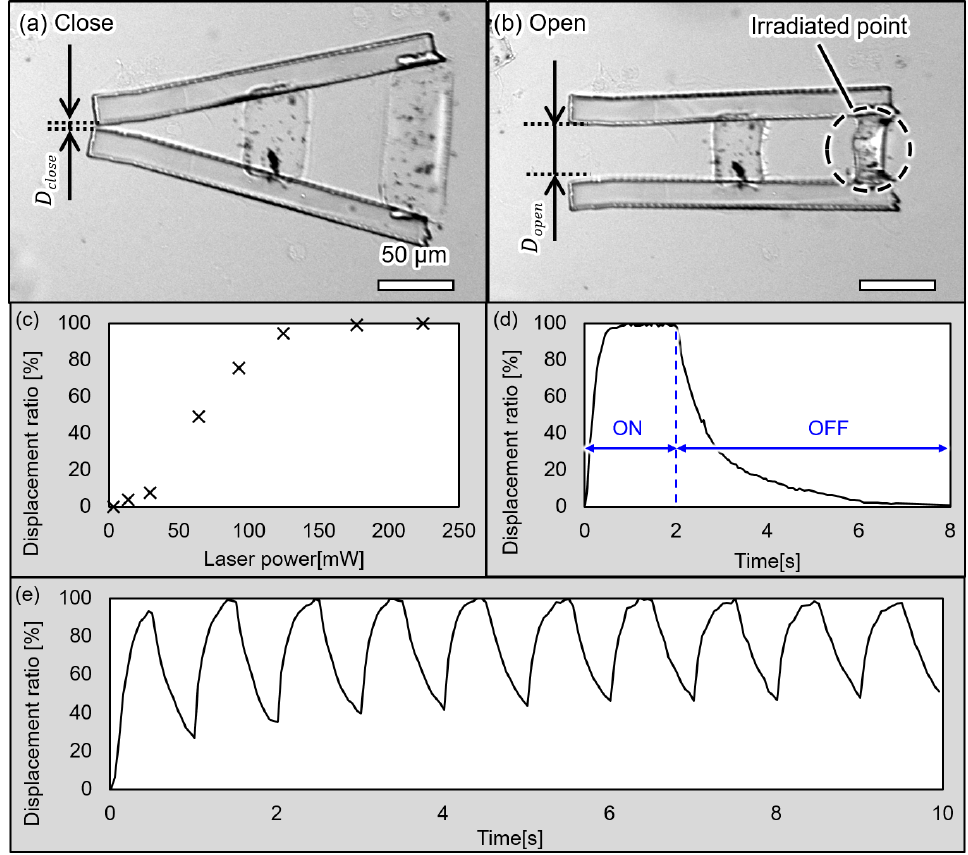
Figure 7. Microscopic images of the microgripper in the ( a ) closed state, ( b ) open state and drive characteristics of the microgripper. ( c ) Displacement ratio at each laser power, ( d ) ON/OFF response of the microgripper, and ( e ) continuous ON/OFF response of the